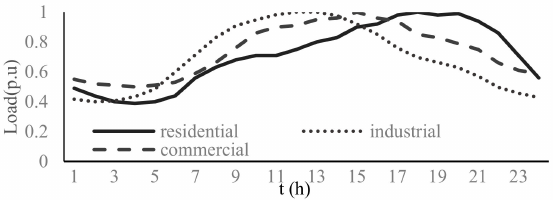
Figure 5. Di ff erent consumers’ load